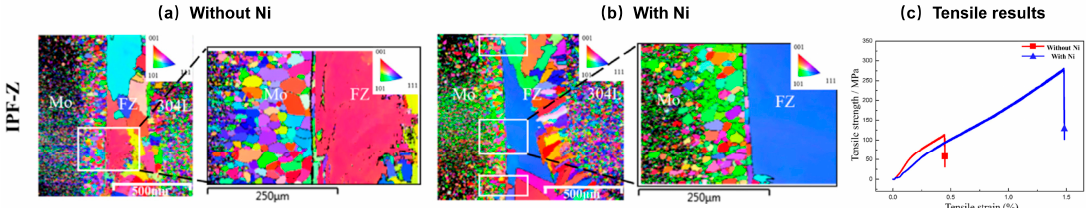
Figure 15. ( a ) Fracture cross section of the joint without Ni, ( b ) fracture cross section of the joint with Ni, and ( c ) tensile results of the two joints [31].